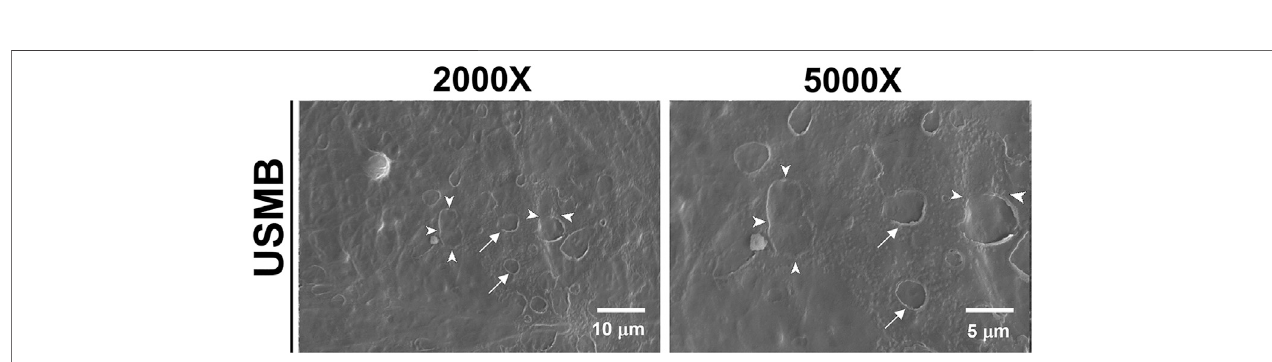
FIGURE 5 | Scanning electron micrographs of the epithelial surface of the RWM. After USMB treatment, the epithelium exhibited sunburn-like peeling, either in separate circular shapes (arrows) or fused forms (arrowheads). USMB, ultrasound microbubble.